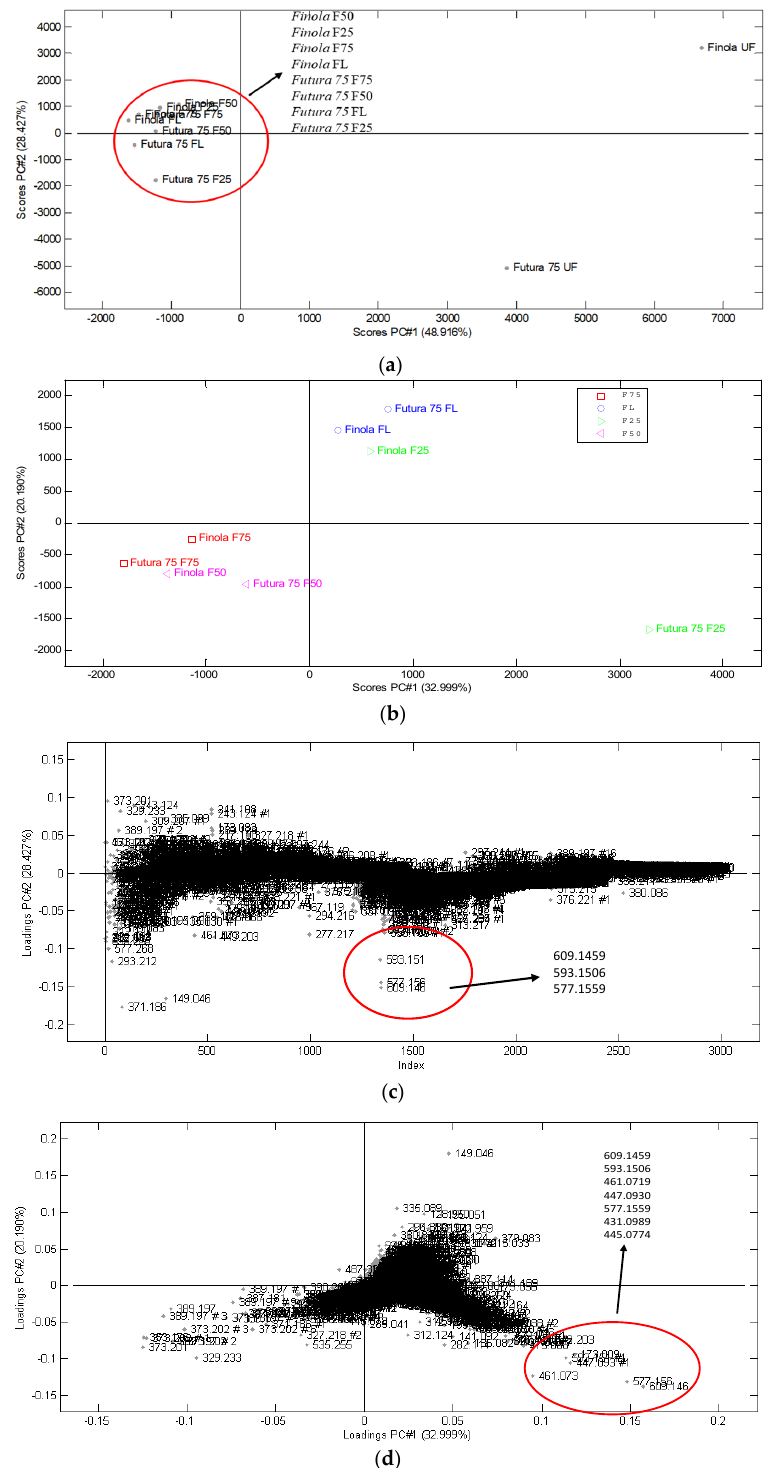
Figure 3. Principal Component Analyses (PCA) scores plots ( a , b ) and their corresponding loadings plots ( c , d ). Scores plot ( a ) shows discrimination between unfractionated extracts of Cannabis sativa L. Futura 75 and Cannabis sativa L. Finola (UF) and their corresponding fractions; flow-through (FL), 25% ACN (F25), 50% ACN (F50), and 75% ACN (F75). Scores plot ( b ) shows grouping of fractions FL, F50, and F75 and discrimination between F25 of Cannabis sativa L. Futura 75 and Cannabis sativa L. Finola . Loading plots ( c , d ) show m/z of metabolites responsible for discrimination. Table 2. Tentatively identified flavonoids glycosides in Cannabis sativa L. Futura 75 .